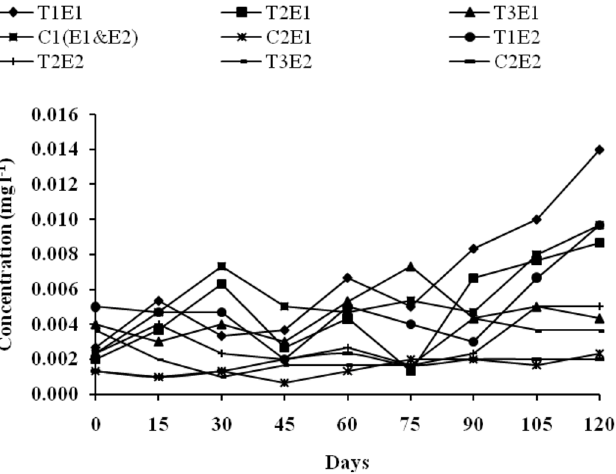
Fig. 3. Temporal changes in NO 2 -N of water inall the treatments of E1 and E2.